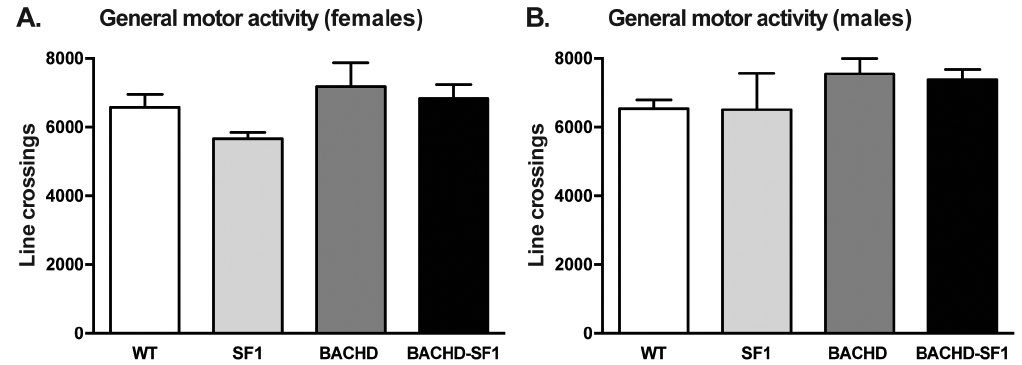
Figure 7. Assessment of motor activity in BACHD-SF1 mice. Motor activity was assessed using the open field test at 4 months of age. Mice were placed in the open field chamber for 1 hour and the total number of line crossings and line crossings in the center were recorded. There were no differences in the number of line crossings (A, B) and in the number of line crossings in the center (C, D) made by BACHD and BACHD-SF1 mice of both sexes compared to their respective WT comparisons. Data presented as mean 6 SEM (Kruskal-Wallis non-parametric ANOVA with Dunn’s multiple comparisons test), n=11–28/genotype/sex in each group. Detailed statistical analyses are outlined in Figure 7 of Statistical Results S1.